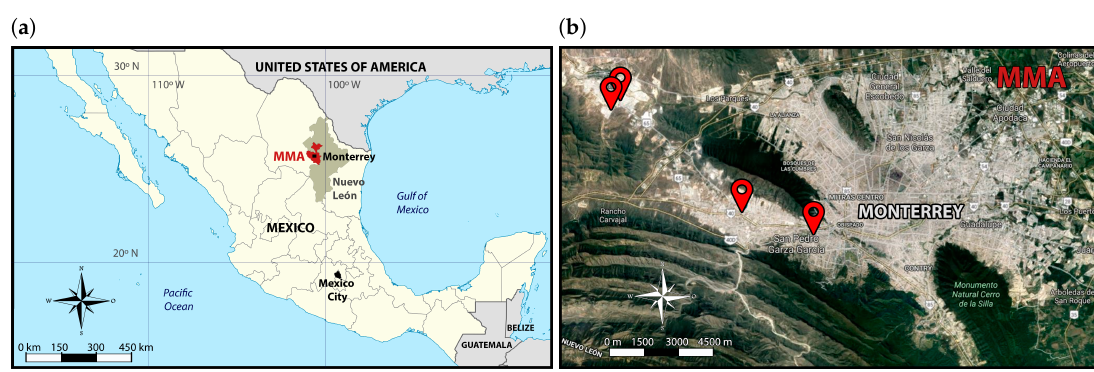
Figure 2. Detailed map on the location of ( a ) Monterrey’s Metropolitan Area (MMA) and ( b ) the respective measurement